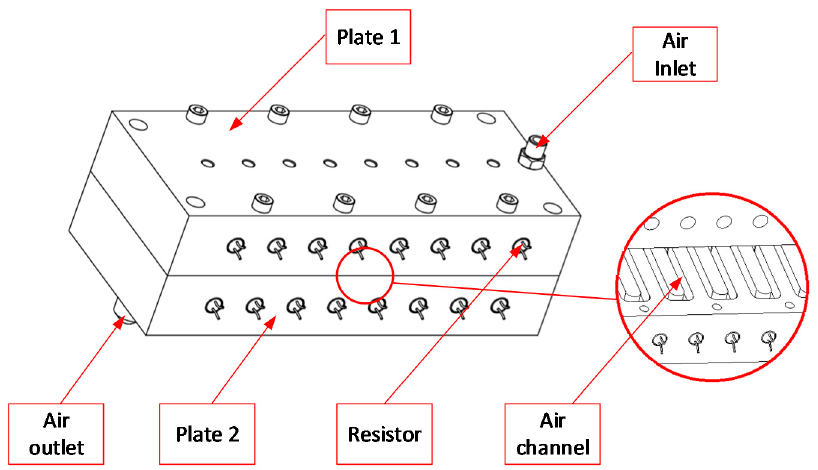
Figure 4. The hot gas generator.